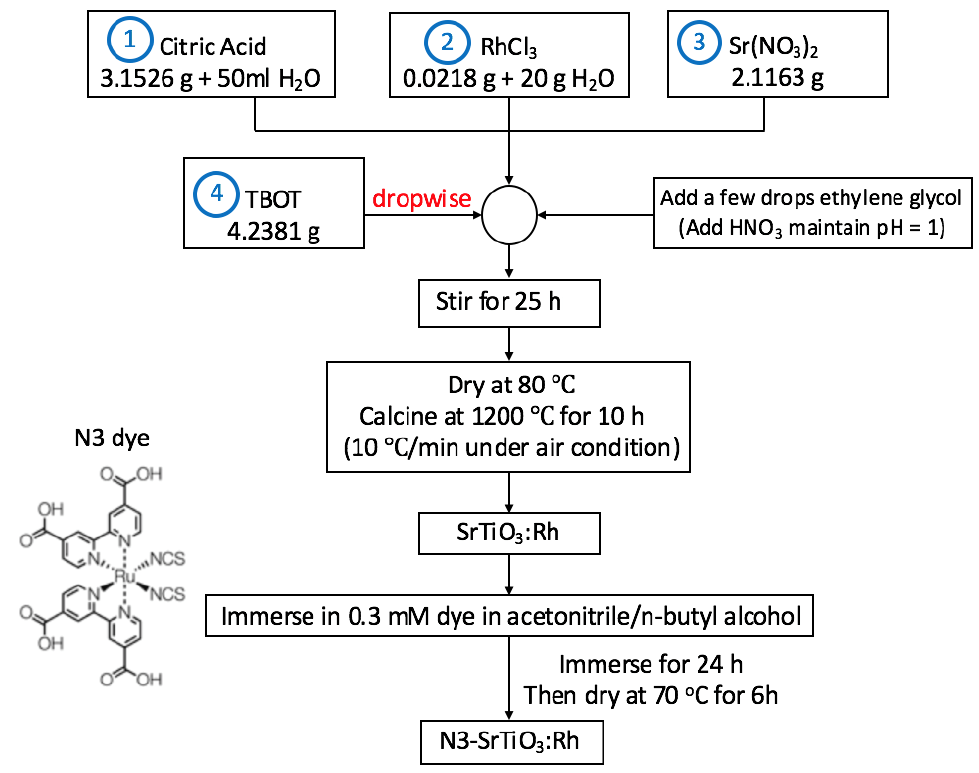
Figure 6. The catalyst synthesizes the procedure by using the modified sol–gel